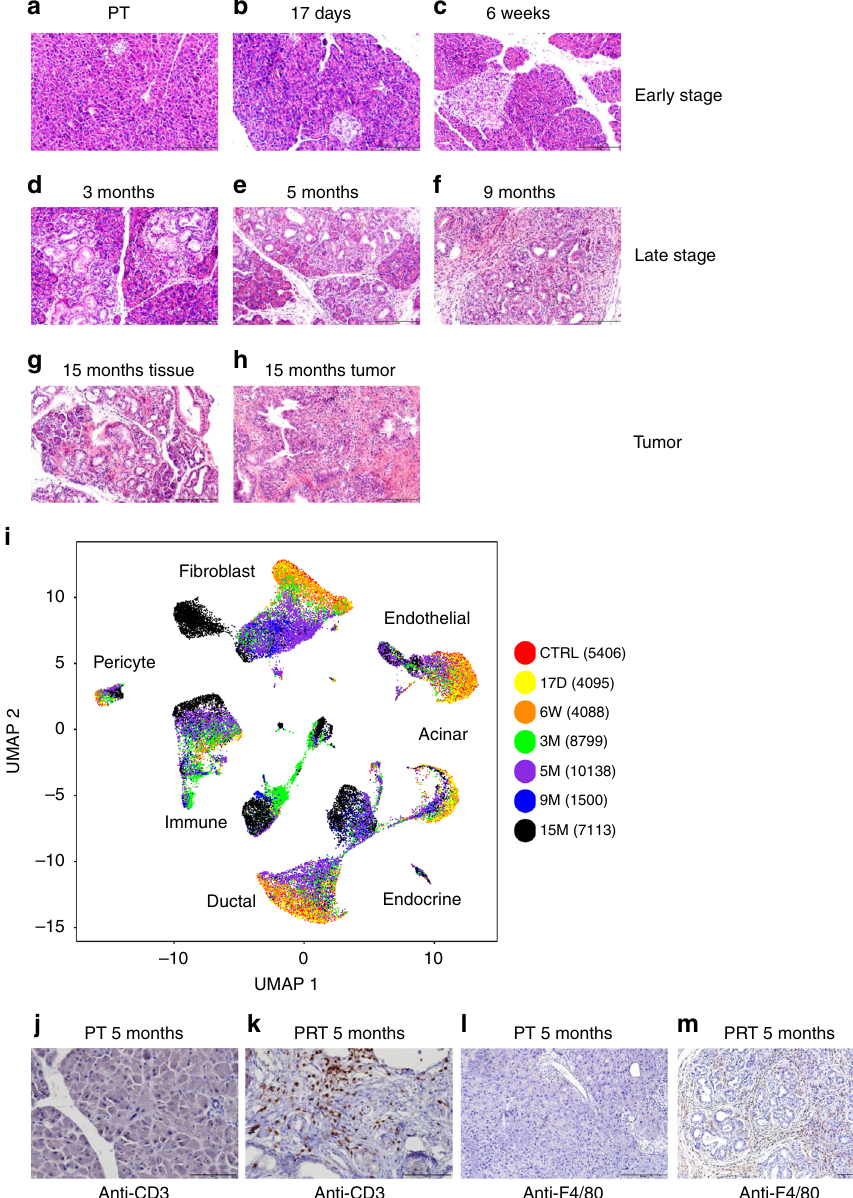
Fig. 1 Single-cell RNA-seq experiment of pancreatic tissue, taken from Ptf1a-CreER, LSL-Kras G12D, LSL-tdTomato mice at different time points post- tamoxifen injection (PTI). a – h The accumulation of duct-like structures and PanINs at different time points post-tamoxifen injection (PTI). Hematoxylin and Eosin (H&E) staining of histological sections of mice pancreas. The time point PTI is indicated above each panel. Based on the number of PanINs and duct-like structures (quanti fi cation in Supplementary Fig. 1a), we de fi ne early stage, late-stage and tumor sample. g , h Two sections from the same mice, g tumor adjacent tissue, and h tumor tissue. In early stage samples, lesions were rare. Scale bars 200 µ m. i Pancreatic tissues from mice were dissected and single-cell RNA-seq experiments were performed. Uniform manifold approximation and projection (Umap) includes all cells from seven different time points PTI. The data were produced from nine mice, two mice from 3 months PTI, two mice from 5 months PTI and one mouse from each of the other time points. Time points are indicated on the right side of the panel, the number of cells is shown in parentheses. Cell types were determined based on the expression level of representative markers as indicated in Supplementary Fig. 1. j , k Immunostaining of pancreatic sections using anti-CD3 antibody. Both sections were taken from fi ve months PTI mice, j control mouse Ptf1a -CreER, LSL - tdTomato (PT), k Ptf1a-CreER , LSL-Kras G12D , LSL-tdTomato (PRT) mouse. Scale bars 100 µ m. l , m Immunostaining of pancreatic section using anti-F4/80 antibody. Both sections were taken from 5 months PTI mice, l control mouse Ptf1a-CreER, LSL-tdTomato (PT), m Ptf1a-CreER , LSL-Kras G12D , LSL-tdTomato (PRT) mouse. Scale bars 200 µ